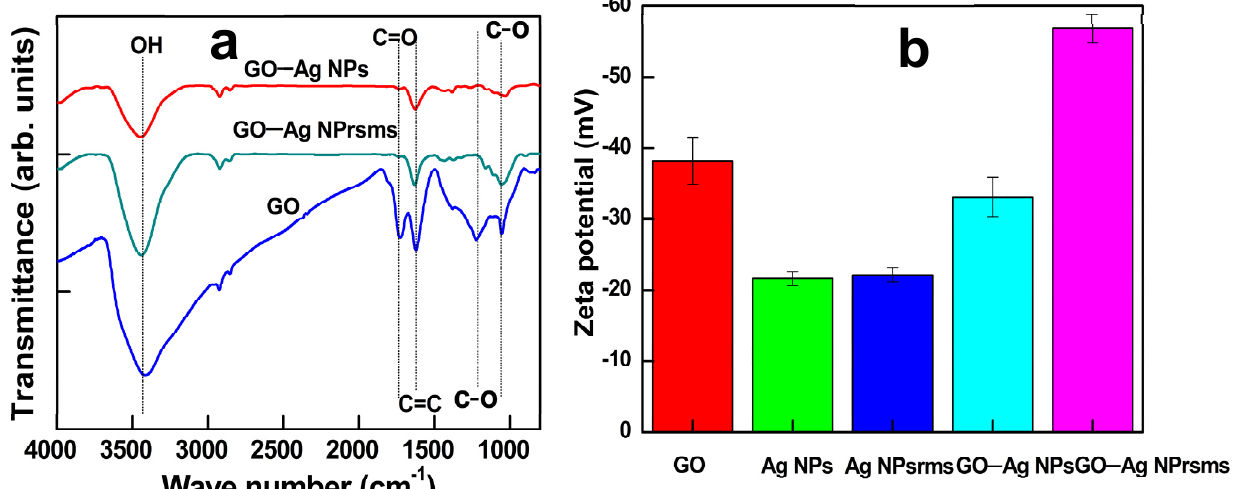
Figure 5. FTIR spectra of ( a ) of GO, GO–Ag NPs and GO–Ag NPrsms and zeta potential ( b ) of GO, Ag NPs, Ag NPrsms, GO–Ag NPs and GO–Ag